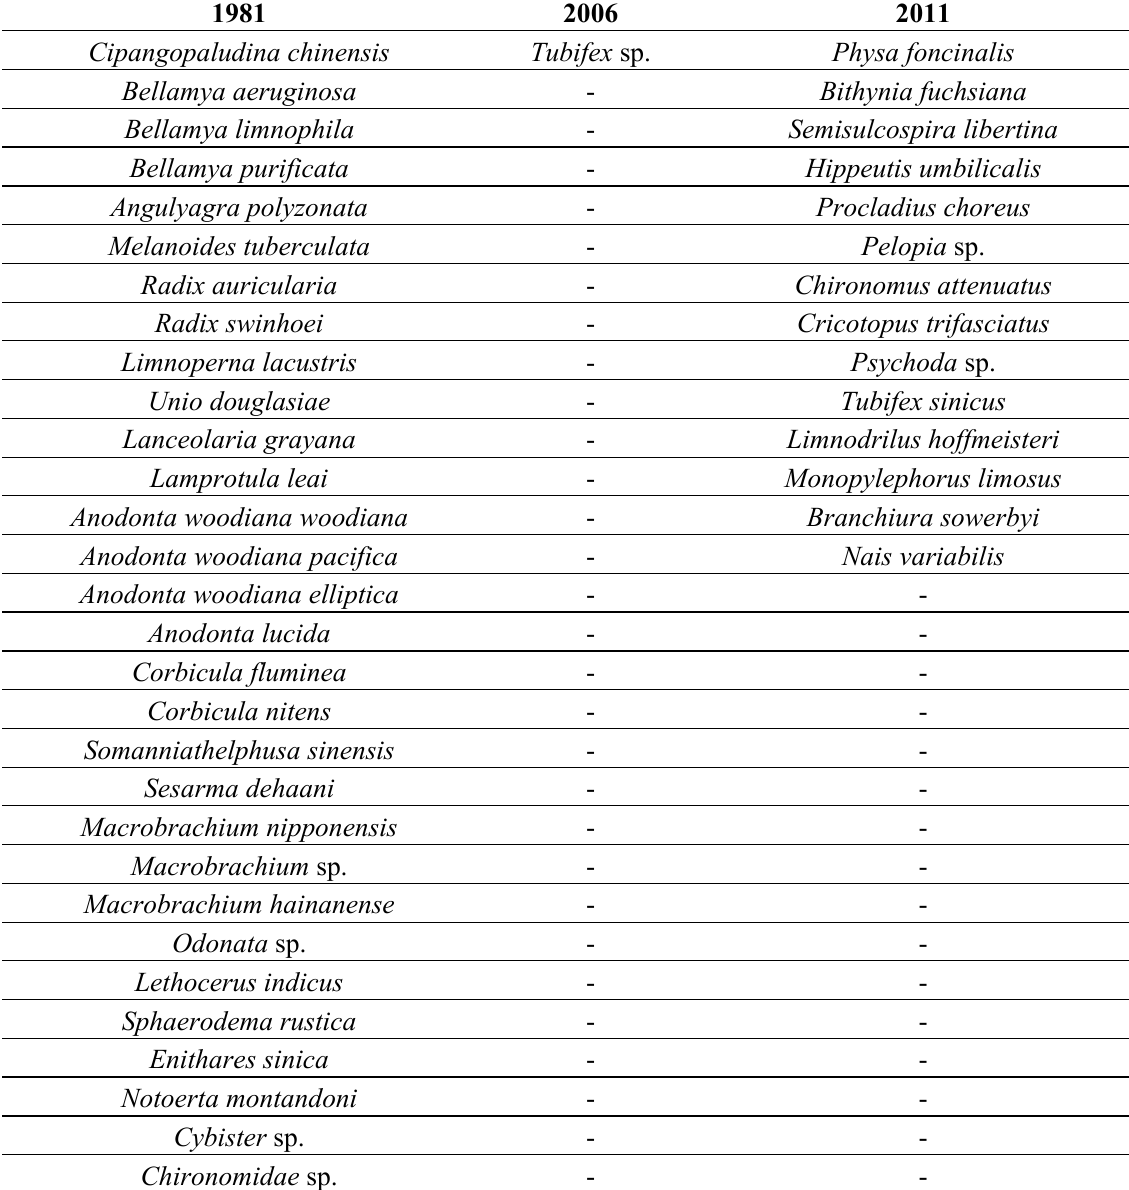
Table 3. The taxa list for the three sampling periods. The 1981 and 2006 data were collected from literature [17,18]. The 2011 data were obtained from the